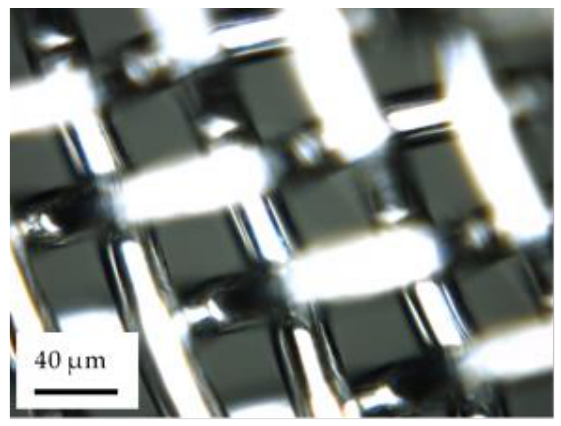
Figure 2. Photograph of the woven wire cloth.